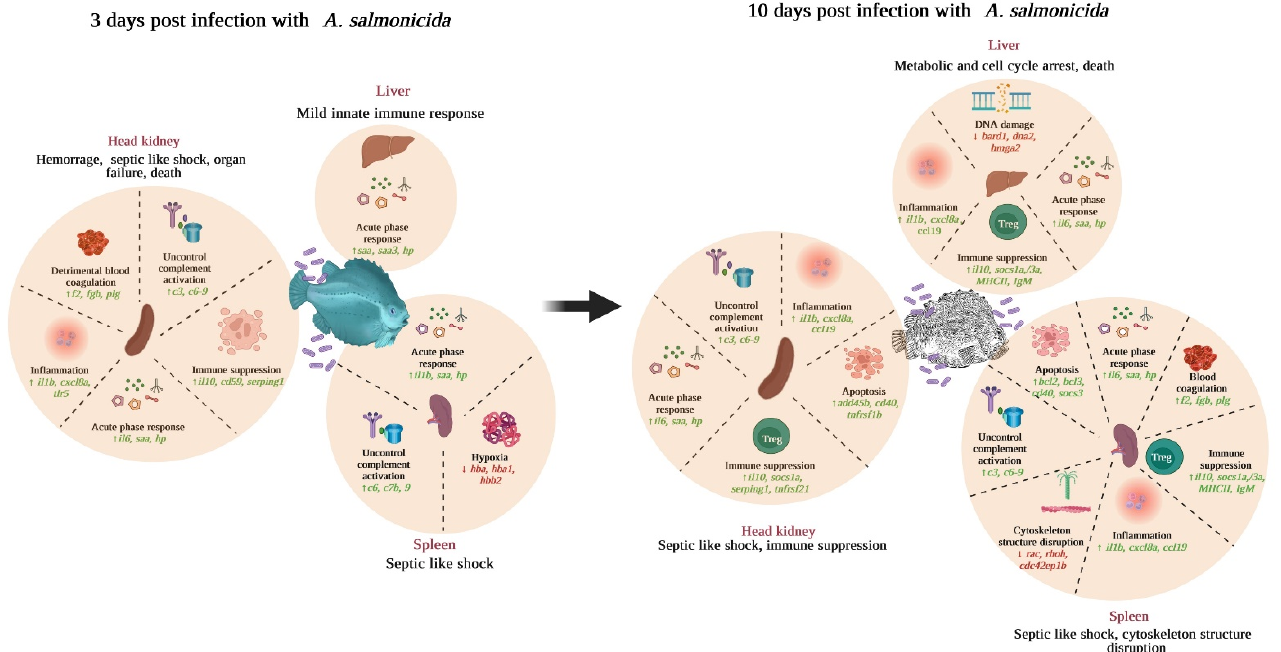
Figure 12. Aeromonas salmonicida infection model in lumpfish lymphoid organs. A. salmonicida early (3 dpi) and late (10 dpi) infection model suggests that A. salmonicida induces lethal infection in